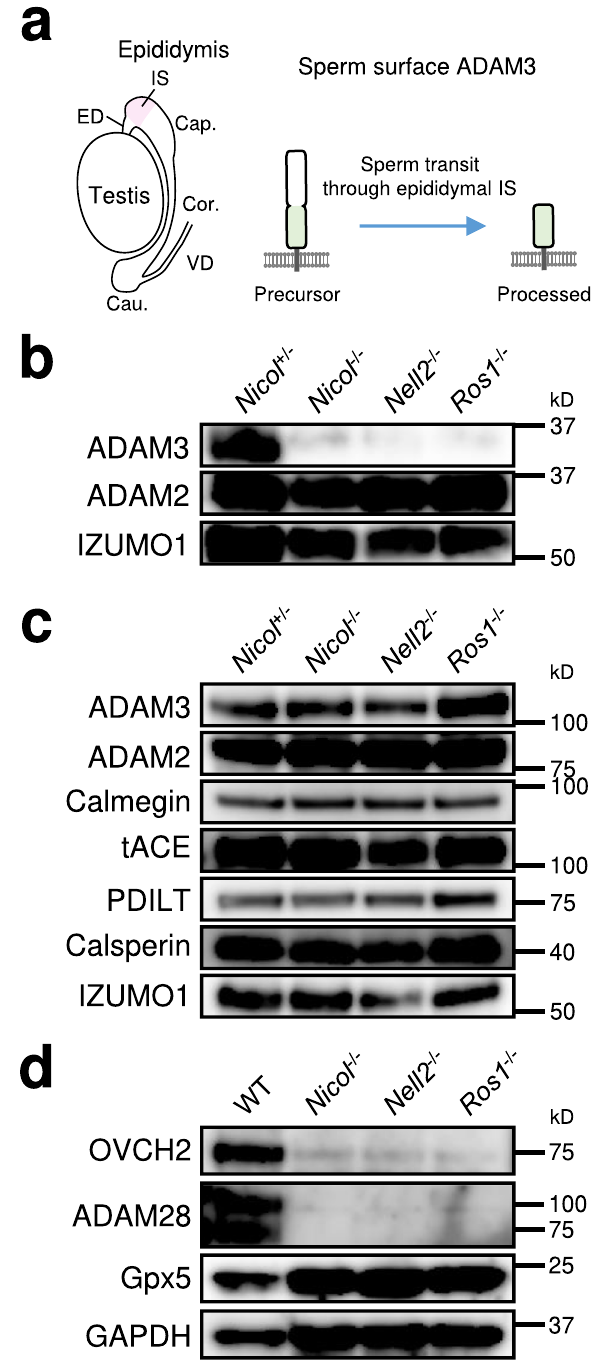
Fig. 3 | Defective epididymal sperm maturation in Nicol − / − male mice. a A schematic representation of ADAM3 processing during sperm transit through epididymal IS. b Expression of proteins associated with sperm ability to migrate into the oviduct and ZP binding of cauda epididymal sperm from Nicol +/ − and Nicol − / − mice. c Expressionofproteinsassociated withspermabilitytomigrateinto the oviduct and ZP binding in testicular germ cells from Nicol +/ − and Nicol − / − mice. d Expression of OVCH2 and ADAM28 in WT, Nicol − / − , Nell2 − / − , and Ros1 − / − IS-caput epididymis.Gpx5andGAPDHshownasinternalcontrols.Imagesarerepresentative ones obtained from three independent biological replicates ( b – d